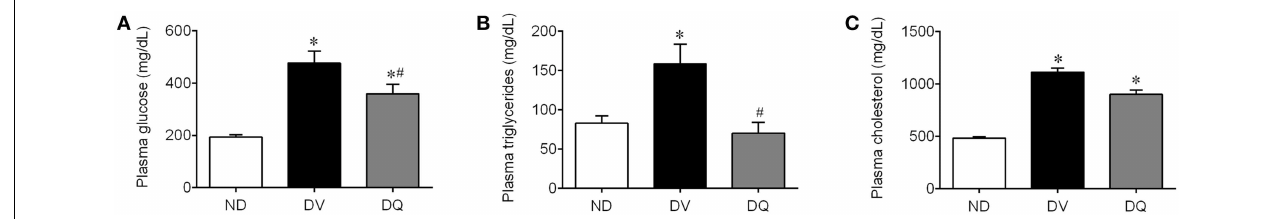
FIGURE 2 | Total plasma glucose (A), triglycerides (B), and cholesterol (C) in diabetic apoE − / − mice treated with quercetin (DQ) compared with diabetic apoE − / − mice administered vehicle (DV) compared with non-diabetic apoE − / − (ND) mice. Values are the means ± SEM for n = 6 –8 mice